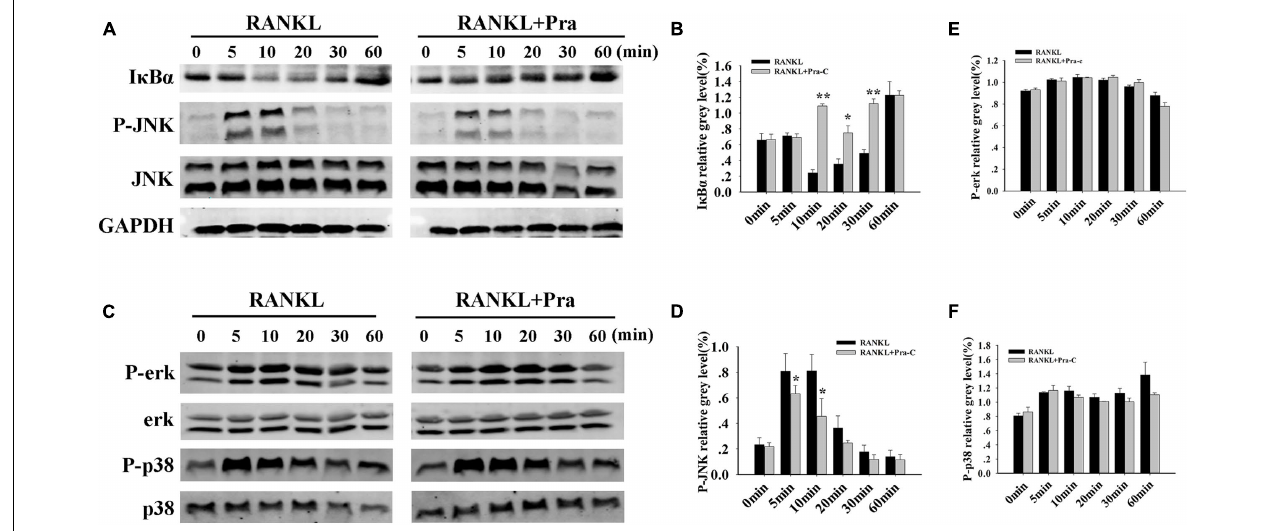
FIGURE 4 | Pra-C impairs RANKL-induced NF- κ B and JNK signaling pathways. (A) Total protein extracted from RAW264.7 cells that had been cultured with or without 20 µ M Pra-C for 4 h, followed by 50 ng/mL RANKL for the indicated times was subjected to western blotting with specific antibodies against I κ B α , phospho-JNK, JNK, and GAPDH. In the control group, I κ B α rapidly degrades, and JNK is rapidly phosphorylated within 10 min. I κ B α degradation and JNK phosphorylation were greatly impaired in the presence of Pra-C. (B) The band intensities corresponding to I κ B α were quantified and normalized to GAPDH levels using Image J software, and are plotted. (C) Western blotting was used to analyze phospho-ERK, ERK, phospho-p38, and p38. No difference was observed in the phosphorylation of these two cascades between the control and Pra-C-treated groups. (D) JNK phosphorylation was quantified and normalized to GAPDH levels, and significant differences were shown between the control and Pra-C-treated groups. No significant differences were found when ERK phosphorylation (E) and p38 phosphorylation (F) were quantified. Values are expressed as means ± SD ( ∗ P < 0.05; ∗∗ P < 0.01 compared to control group). All the experiments were performed at least three times and representative blots are shown in panels (A,C)